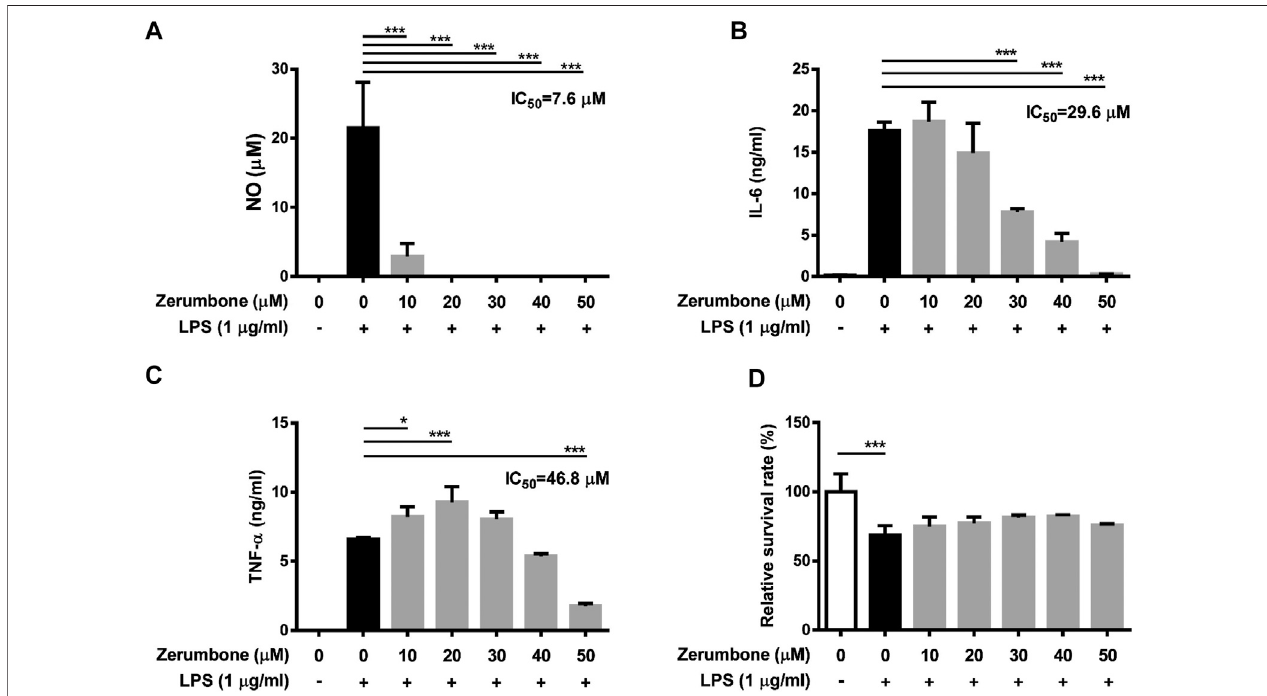
FIGURE 6 | The effects of zerumbone on the NO, IL-6, and TNF- α productions and cell viability in LPS-activated murine peritoneal macrophages. Cells were pre- treated with various doses of zerumbone for 1 h following treatment of LPS (1 μ g/ml) for 24 h. (A) The production of NO was determined by Griess reagent assay. The expression levels of (B) IL-6 and (C) TNF- α were measured using ELISA. Statistical signi fi cance between the zerumbone-treated groups vs. the LPS-only group is represented as follows: * p < 0.05 and *** p < 0.001. (D) Cell viability was analyzed by MTT assay. Data were represented as means ± SD. Statistical signi fi cance is represented as follows: *** p < 0.001, compared with the LPS-only